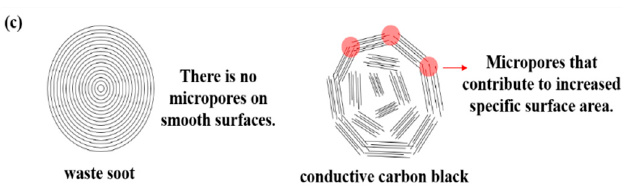
Figure 6. Schematic of the formation mechanism and structure of ( a ) waste soot and ( b ) commercial conductive carbon black. ( c ) The relationship between surface structure and surface area.